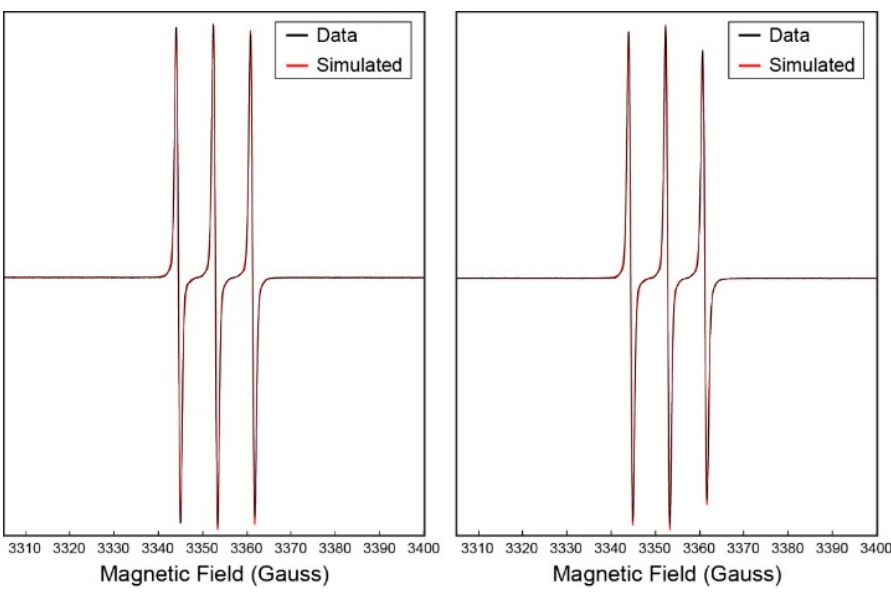
Figure 5. Experimental (black line) and simulated (red line) spectra of the non-interacting solutions (stock solutions) of CAT1 and CAT8 probes (named as Bn).